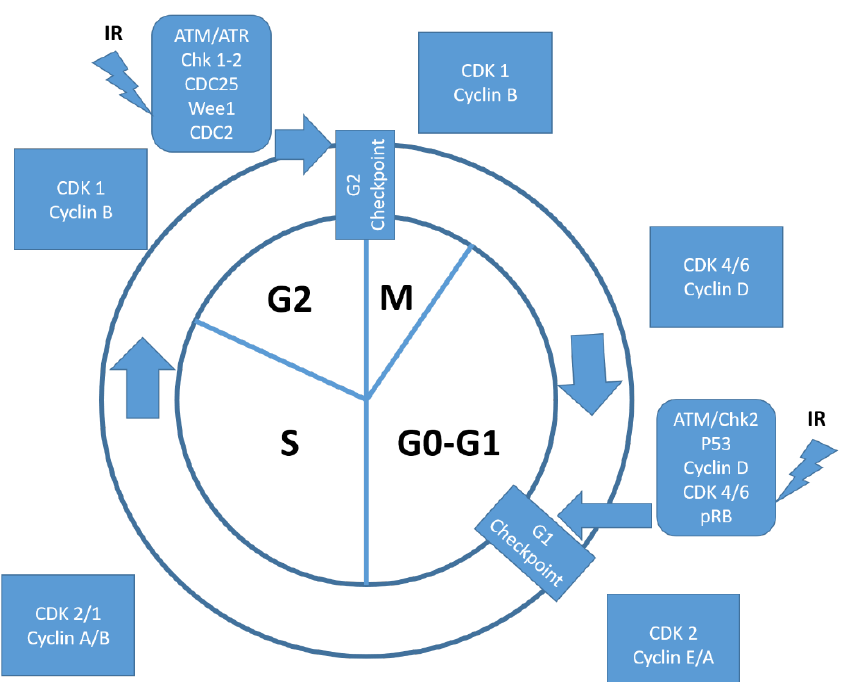
Figure 1. Schematic overview of cell cycle regulation, with an emphasis on radiotherapy-induced pathways and CDK/cyclin regulation. In M phase and in G2 resting phase, cancer cells are respec- tively very sensitive and moderately sensitive to radiation injury, whereas in G1 phase and in S phase, cancer cells are moderately resistant to radiation injury. Irradiation induces G1 and G2 cell cycle checkpoint activation and DNA repair. Most cancer cells are defective in G1 checkpoint, commonly due to the mutations/alterations of the key regulators of the G1 checkpoint, but contain a functional G2 checkpoint.